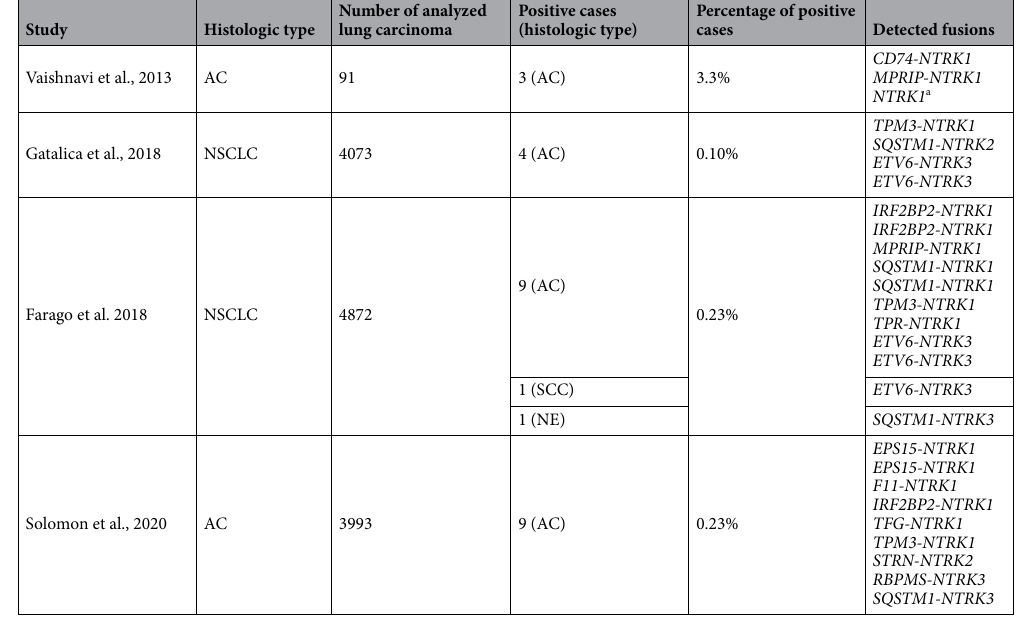
Table 2. Distribution of fusion partners according to the histologic type in published studies. AC adenocarcinoma, NSCLC non-small cell lung carcinoma, SCC squamous cell carcinoma, NE